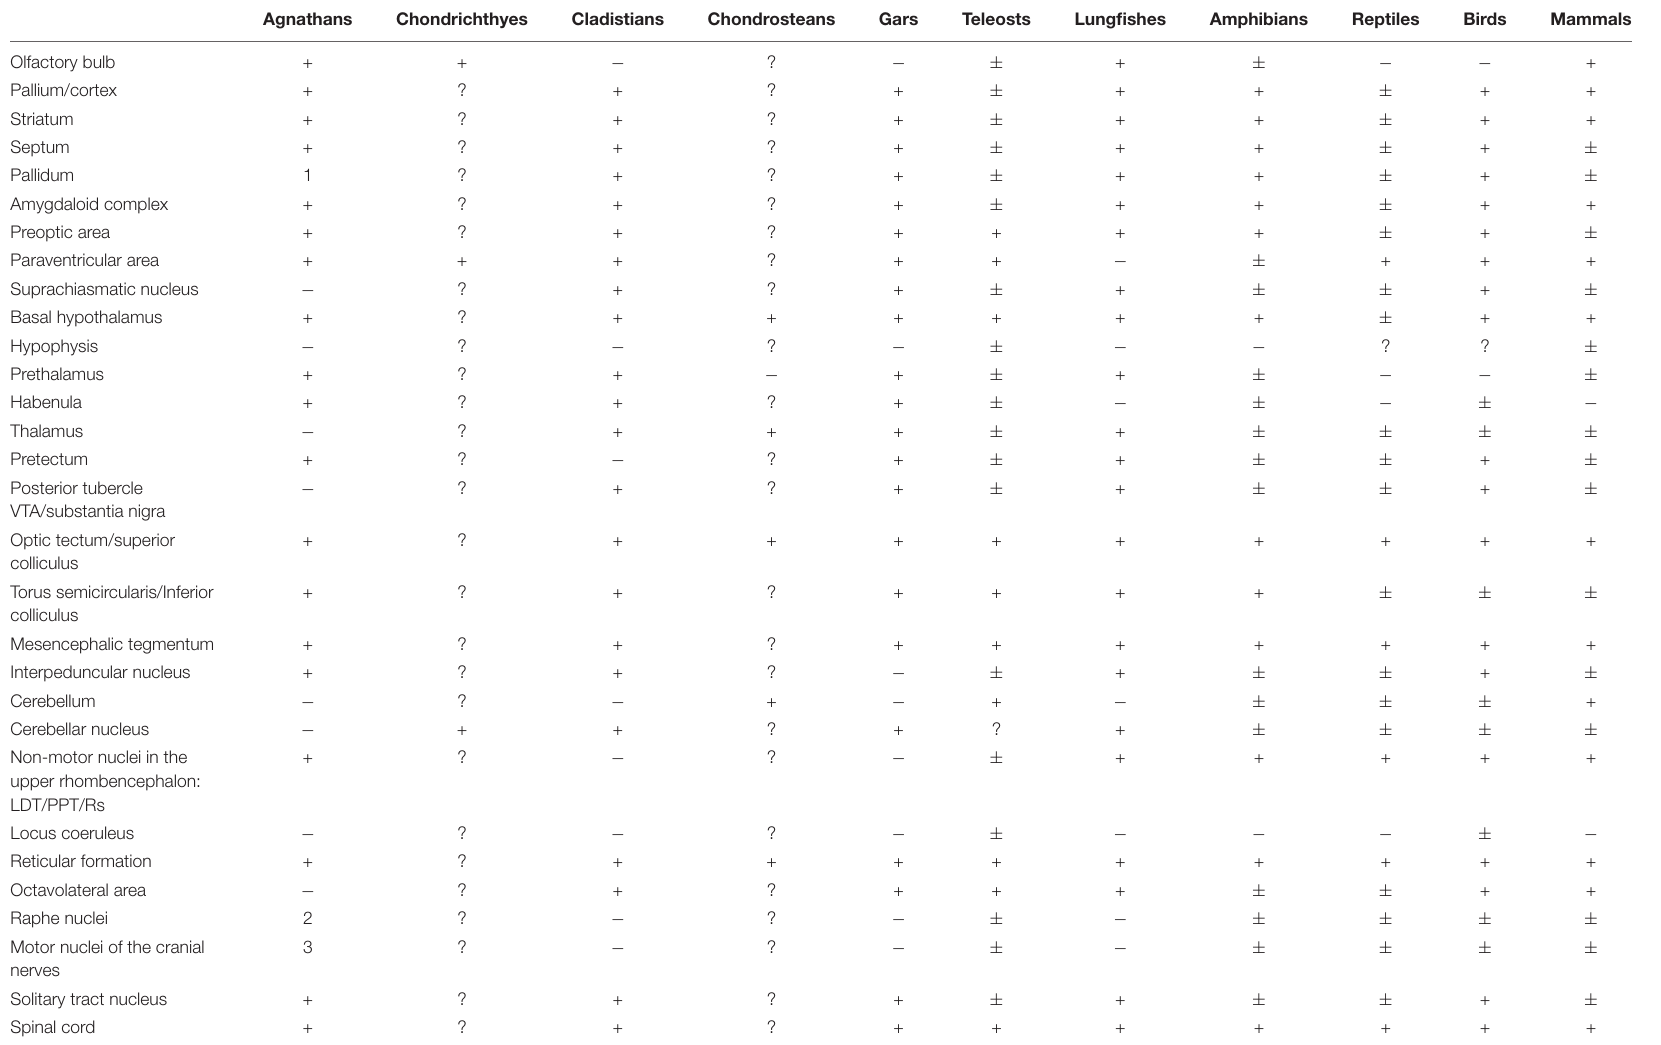
(+) Presence of labeled cells; ( − ) absence of labeled cells; ( ± ) presence of labeled cells in some species of the group; (?) no data available; (1) a putative pallidum was suggested by Stephenson-Jones et al. (2011) to be located in the area interpreted by us as prethalamic eminence (Pombal et al., 2009); therefore, at least part of the cells included in our NSM appear to distributed in the putative pallidum; (2) some of the